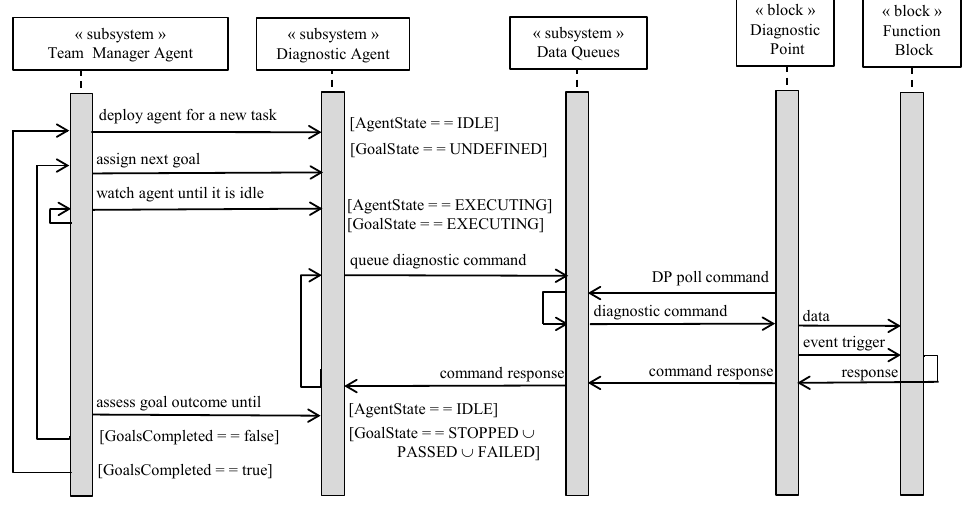
Figure 6. GORITE Team, agent, and diagnostic point processes across the execution